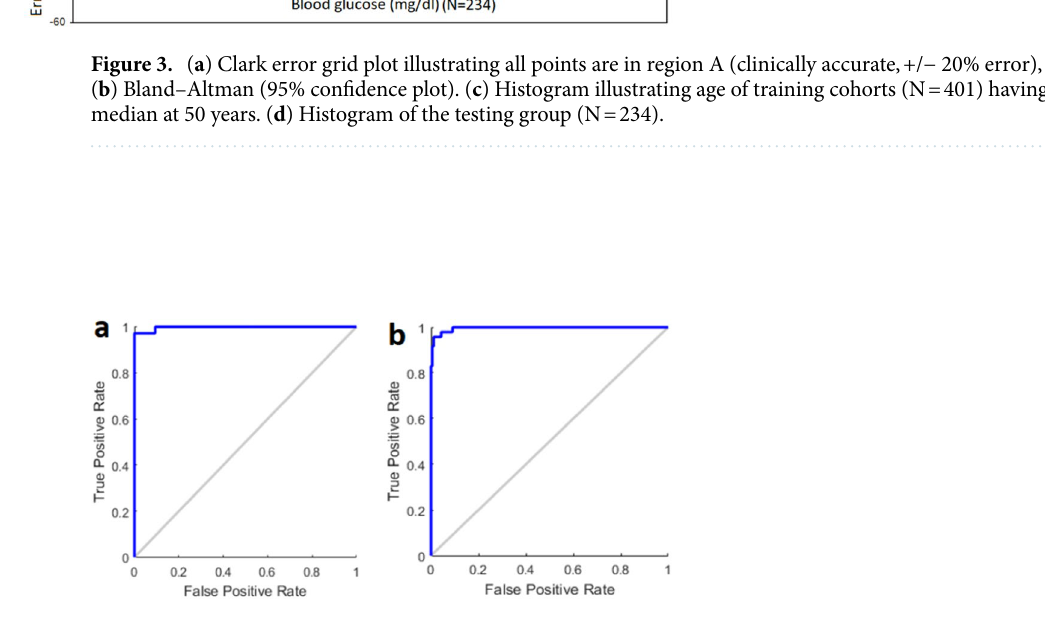
Figure 4. ROC plot in DM classification in ( a ) training data ( b ) test